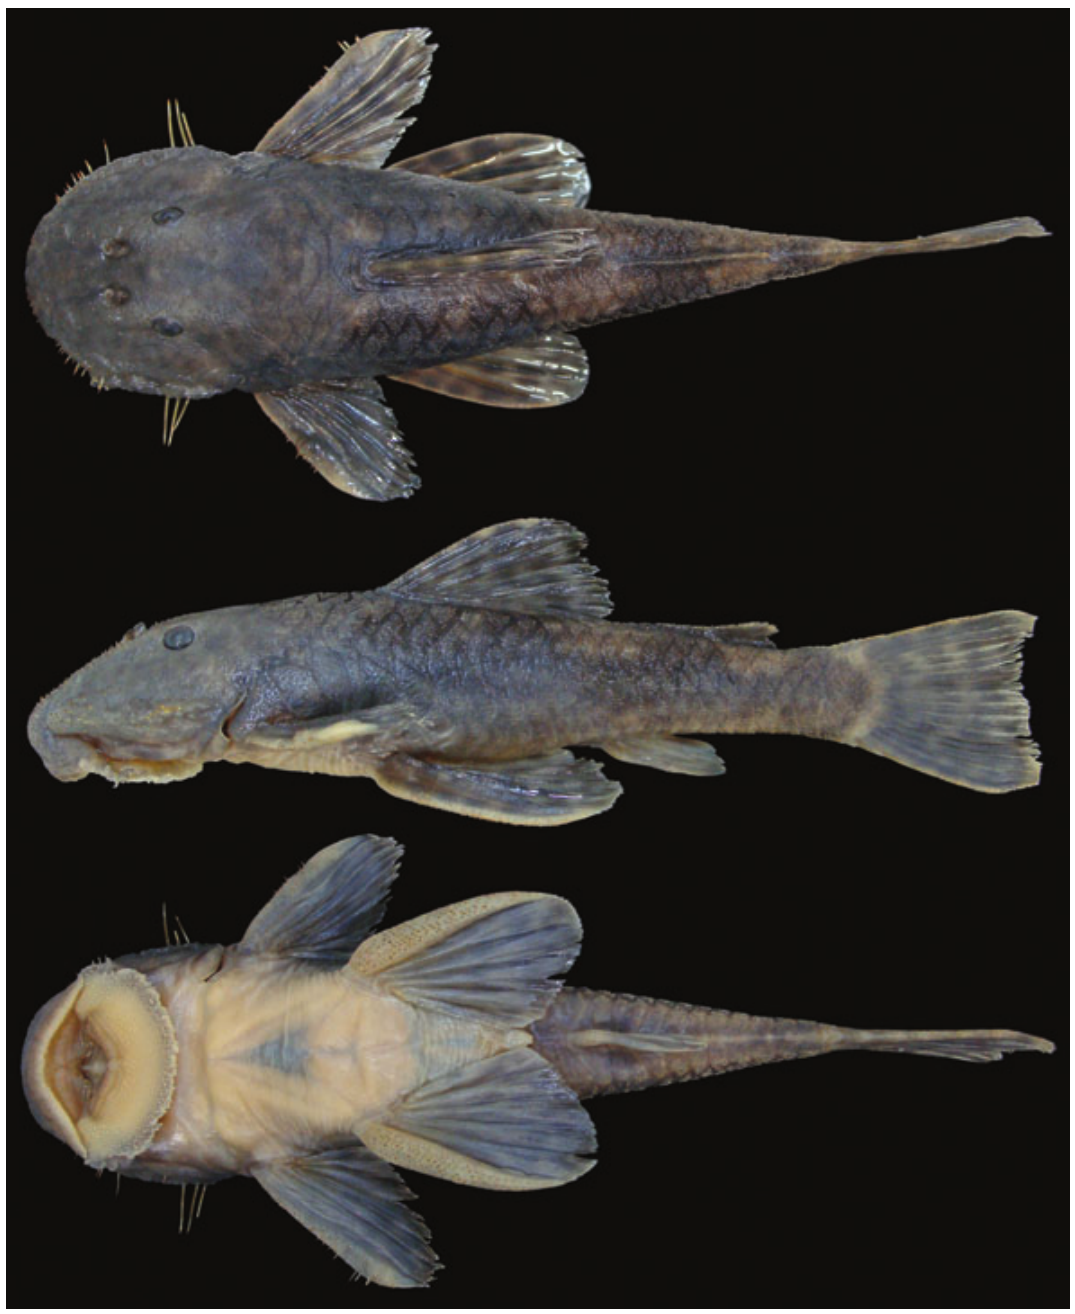
Fig. 1. Pareiorhaphis ruschii , MCP 46640, holotype, 84.7 mm SL, male, Brazil, Espírito Santo State, Santa Teresa